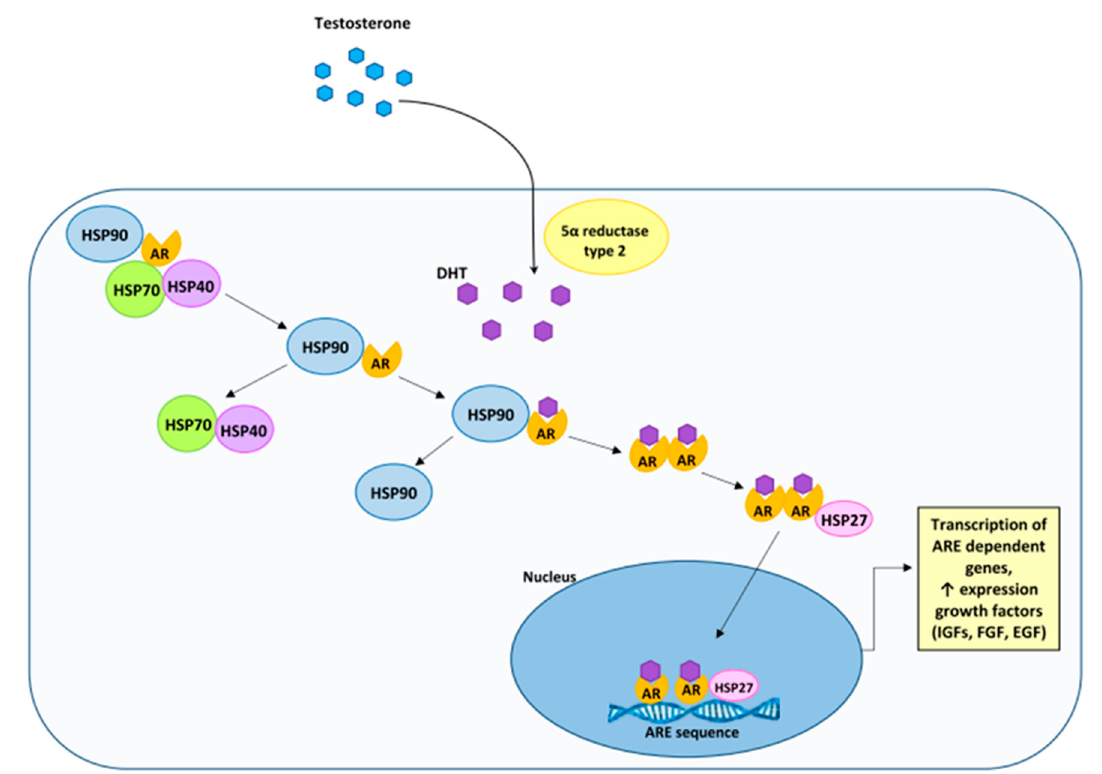
Figure 4. Androgen-AR action in the prostate cells. HSPs regulate AR signaling. A complex of chaperones, including HSP90, associates with the AR to expedite and maintain its high affinity binding conformation, thus allowing for DHT interaction. Testosterone (T) and DHT bind to AR and promote the association of AR coregulators. AR dimer then translocates to the nucleus and binds to AREs sequences in the promoter regions of target genes to induce cell proliferation and apoptosis.